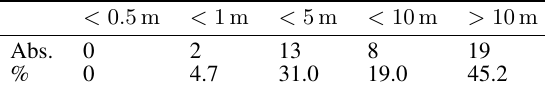
Table 4. Absolute differences ( ∆ XYZ) of camera poses sorted into five categories. The absolute number of cameras as well as the percentage value is